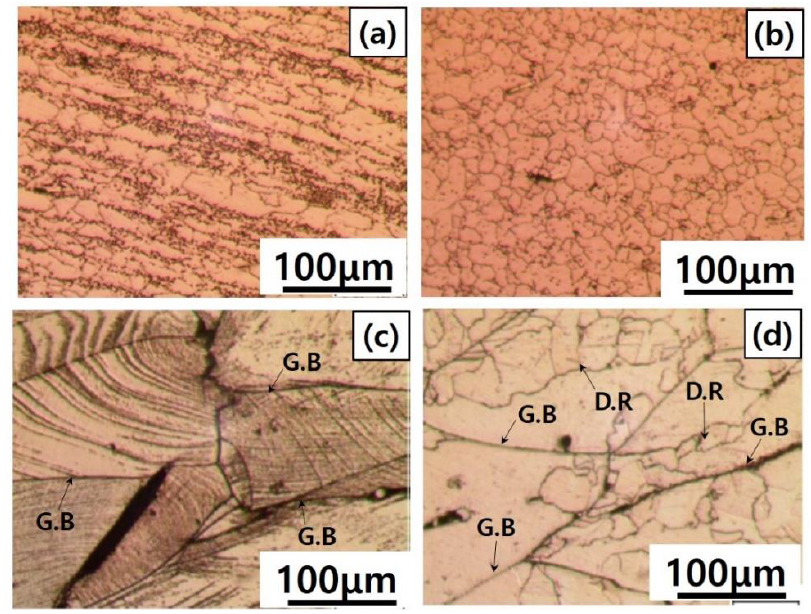
Figure 12 . Longitudinal cross sectional views of as-rolled ( a , b ) and annealed (1200 °C, 24 h) ( c , d ) high- nitrogen, high-carbon Fe-Cr-Mn-Ni steels fractured at 1000 °C ( a , c ) and 1100 °C ( b , d